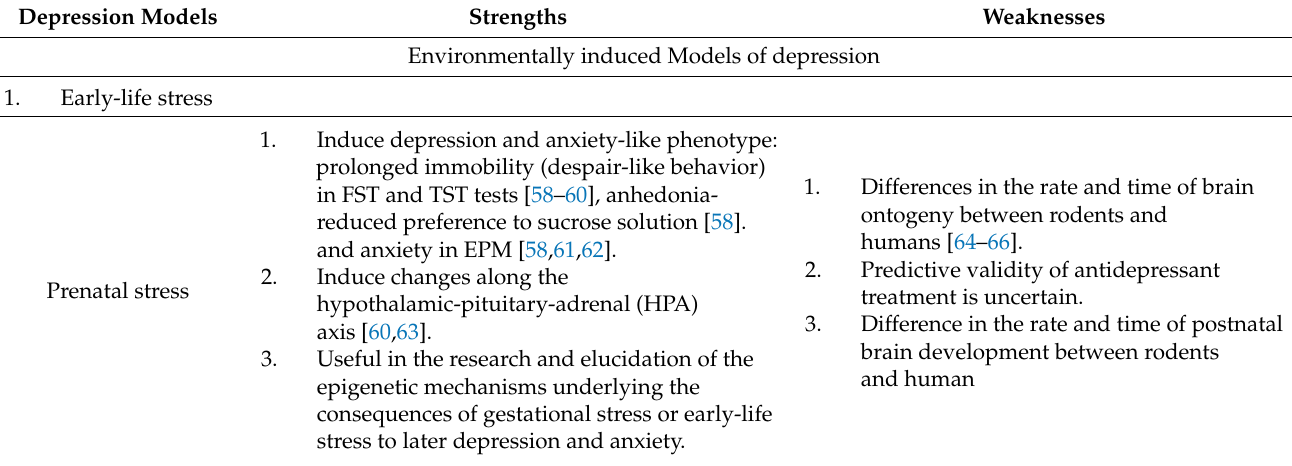
Table 1. Strengths and weakness of animal models of